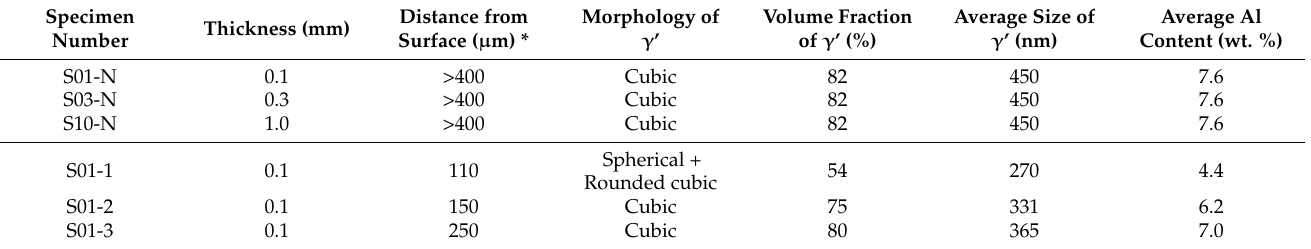
Table 1. Detailed information of studied superalloy specimens for oxidation tests at high